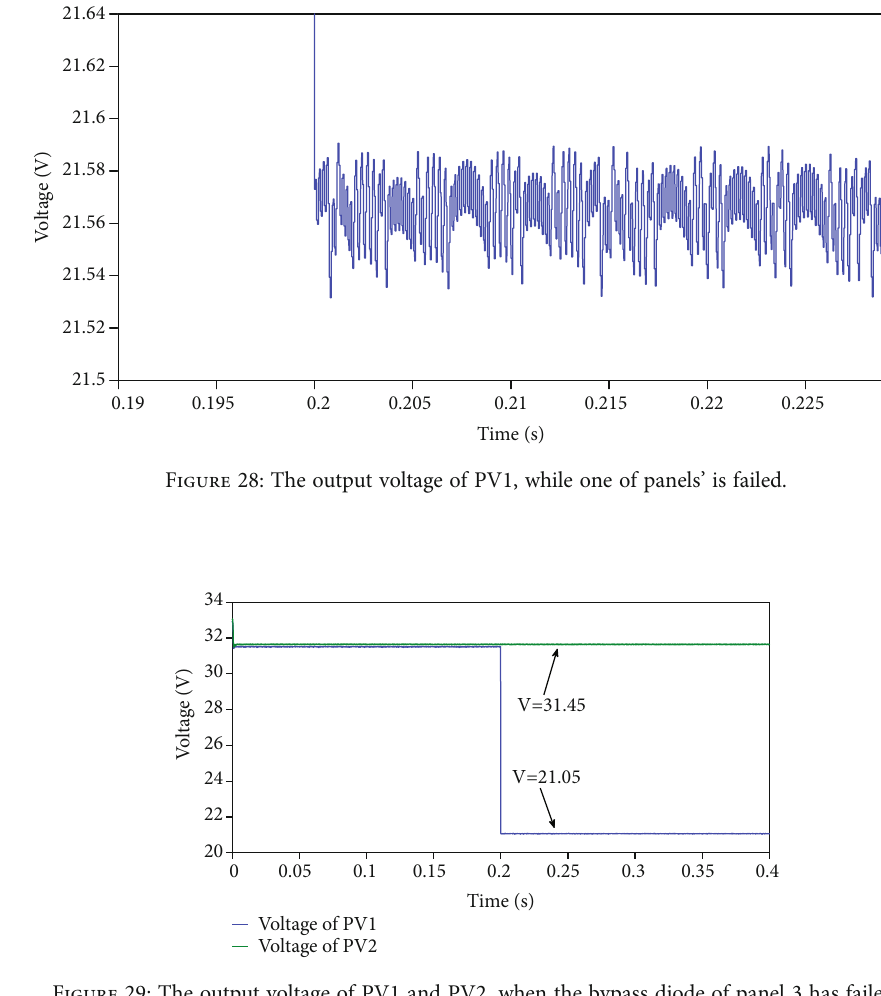
Figure 29: The output voltage of PV1 and PV2, when the bypass diode of panel 3 has failed.